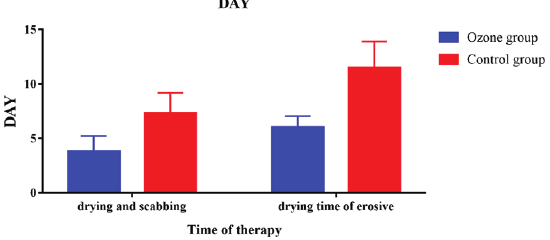
Figure 2. Different treatment vesicle dry scab, erosion drying time (day) box chart. overall BPDAI score and the scores of all clinical obser-